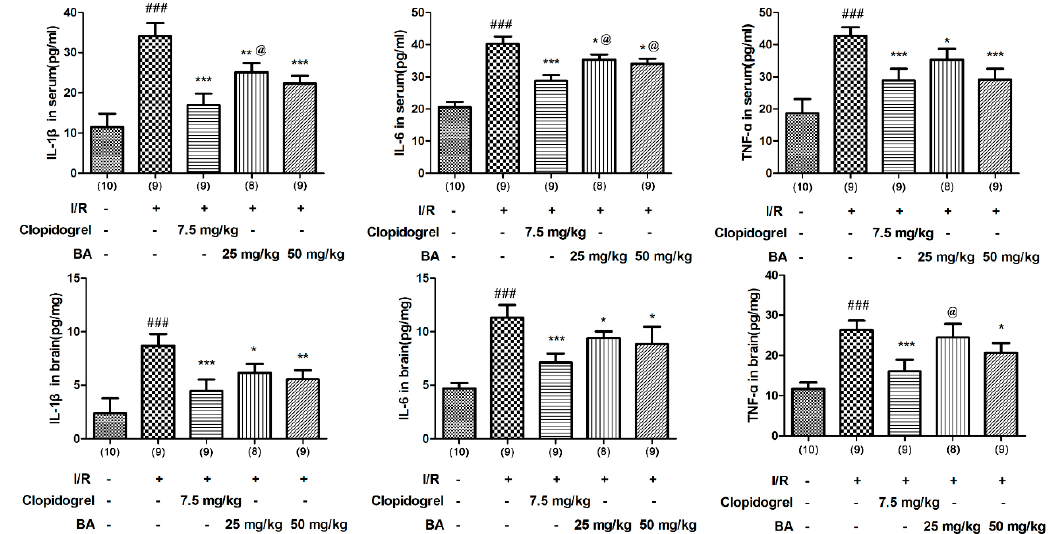
Figure 3. The beneficial effects of BA on the level of inflammatory cytokines in serum and brain tissues compared with sham rats (### p < 0.001), compared with I / R group (* p < 0.05, ** p < 0.01, and *** p < 0.001) and compared with clopidogrel group (@ p < 0.05). The Arabic number in brackets represent the numbers of animals in each group.